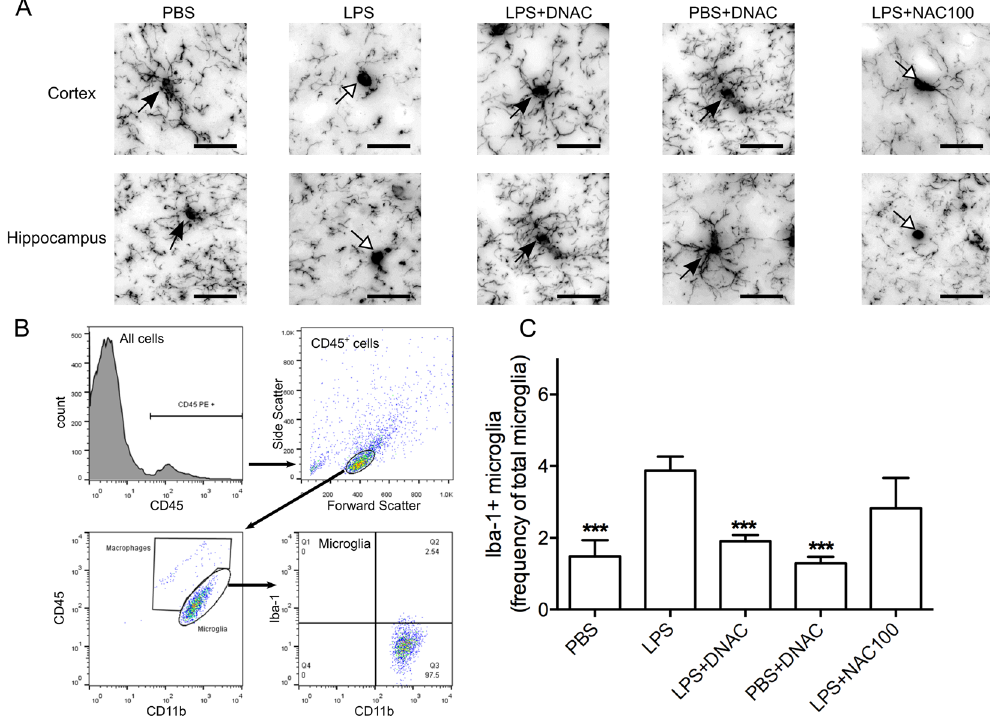
Figure 5. Immunohistochemical staining (IHC) and flow cytometric analysis of postnatal microglial activation at PND17. ( A ) At postnatal day (PND) 17, LPS-exposed offspring had increased numbers of activated microglia (less cell ramification and more amoeboid shape, white arrows) in the cortex and hippocampus compared to PBS and dendrimer N -acetyl- L -cysteine (DNAC) treatment groups (black arrows). ( B ) Methodology of flow cytometry on microglial activation. Single-cell suspensions were prepared from brains, stained with CD45, CD11b, and Iba-1 antibodies, and analyzed by flow cytometry. Microglia was identified as CD11b + /CD45 + and Iba-1 expression was assessed to measure microglial activation. ( C )Based on the methodology of ( B ), LPS- exposed offspring had an increased number of Iba-1 + microglia compared to PBS. DNAC treatment resulted in reduced numbers of activated microglia versus LPS alone. ( *** p < 0.001; One-Way ANOVA; n = 6 PBS litters, 9 LPS litters, 5 LPS + DNAC litters, 4 PBS + DNAC litters, 3 LPS + NAC100 litters). Images are 100 × magnification, and scale bars represent 5 μ